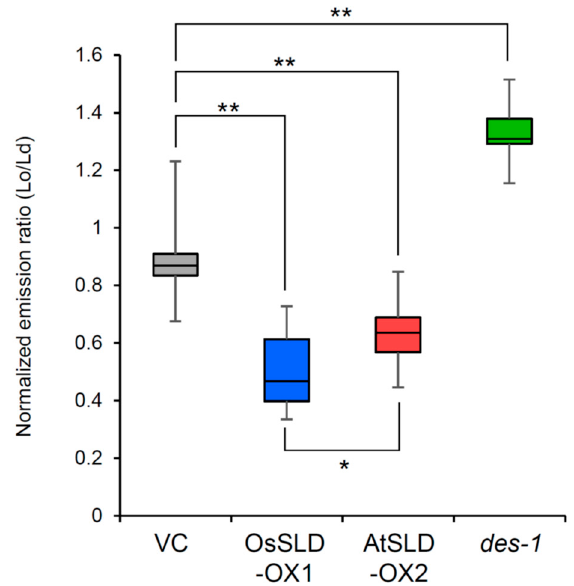
Figure 5. Membrane order in transgenic rice plants. Plasma membrane fluidity was analyzed using normalized liquid-ordered (Lo) and liquid-disordered (Ld) emission using di-4-ANEPPDHQ. Data are presented as box plots, with the boxes representing the interquartile range. Lines extend from the box to the highest and lowest values. The median value is represented by the thick line across each box. Statistical significance was assessed by one-way ANOVA ( n = 11–14, * P < 0.01, ** P < 0.001).